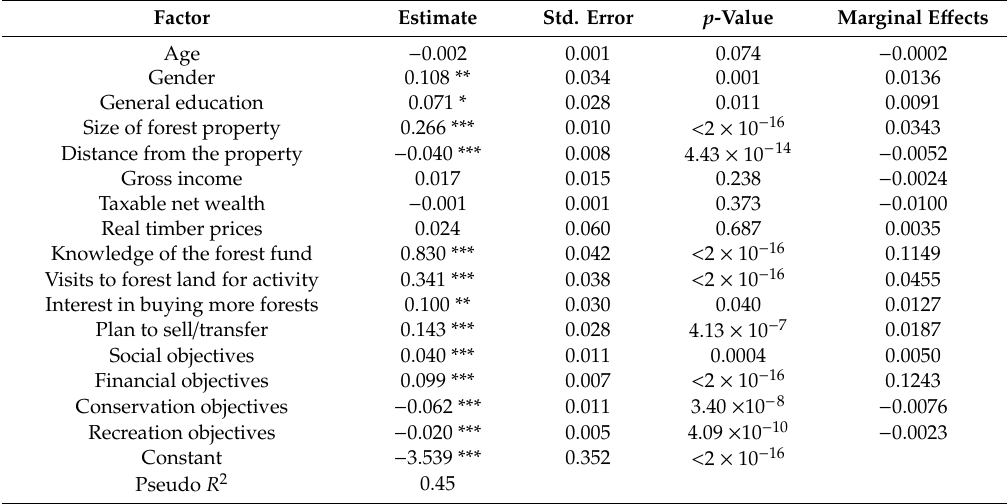
Table 3. Parameter estimates and marginal effects of the probit model in the period 2003–2012 ( N = 16,370 over 10 years).